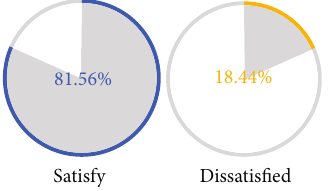
Figure 9: Satisfaction survey results of tested smart car